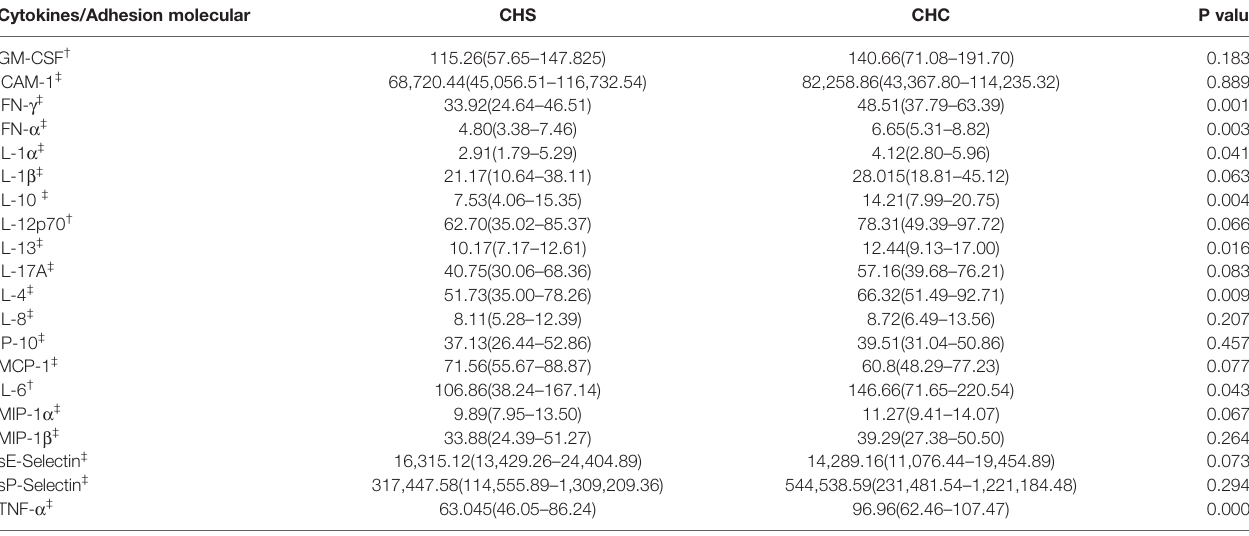
TABLE 4 | Concentrations (pg/ml) of different cytokines in patients who spontaneously cleared HCV (CHS) and who developed chronic HCV infections (CHC). Cytokines/Adhesion